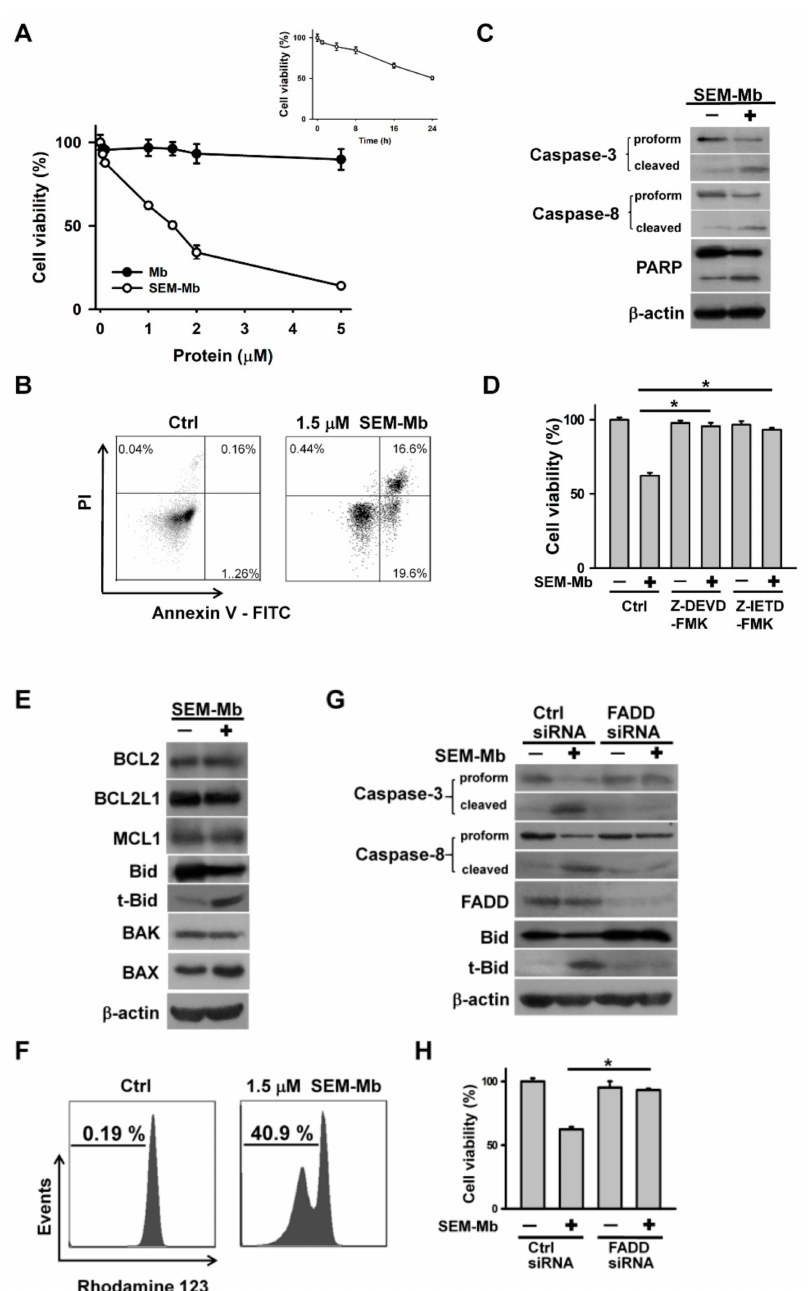
Figure 1. SEM-Mb-treated U937 cells underwent apoptosis. Without specific indication, U937 cells were treated with 1.5 µ M SEM-Mb for 24 h. ( A ) SEM-Mb induced cell death in a concentration- and time-dependent manner. U937 cells were incubated with varying concentrations of SEM-Mb or Mb for 24 h. Cell viability was determined by MTT assay. Results are expressed as the percentage of cell survival relative to the control. Each value is the mean ± SD of triplicate determinations. (Inset) U937 cells were incubated with 1.5 µ M SEM-Mb for indicated time periods. ( B ) Flow cytometry analyses of SEM-Mb-treated U937 cells using annexin V-FITC/propidium iodide double staining. (Left) Untreated control cells. (Right) U937 cells were treated with 1.5 µ M SEM-Mb for 24 h. On flow cytometric scatter graphs, the left lower quadrant represents remaining live cells. The right lower quadrant represents the population of early apoptotic cells. The right upper quadrant represents